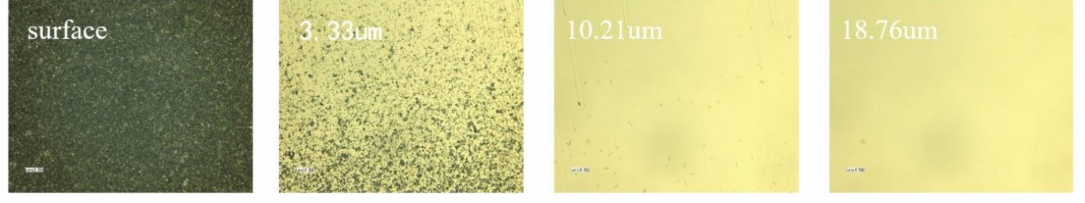
Figure 9. SSD results of sample 1.